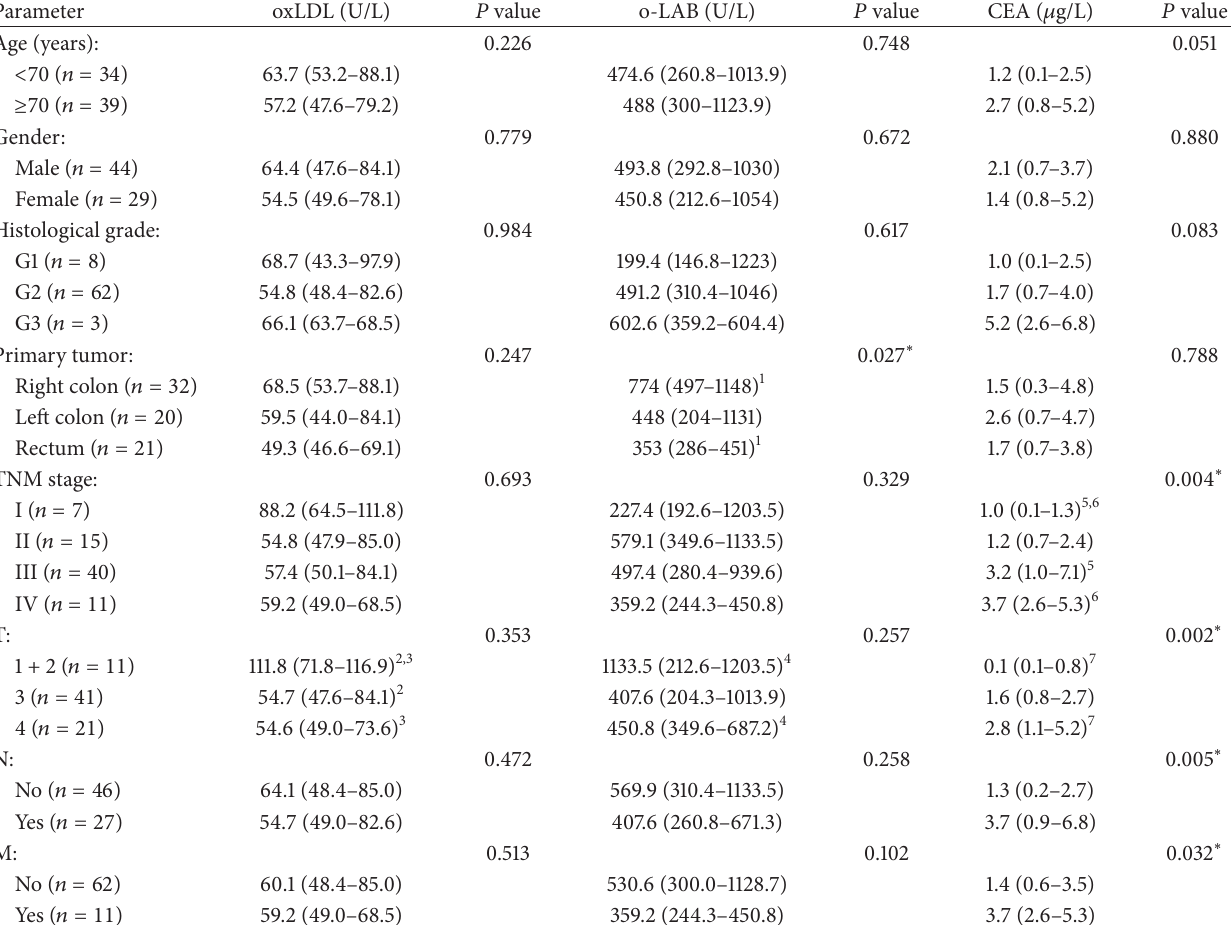
Table 4: Relationships between serum levels of oxLDL and o-LAB and clinicopathological characteristics of patients with CRC ( 𝑛 = 73 ). Data are presented as median (interquartile range